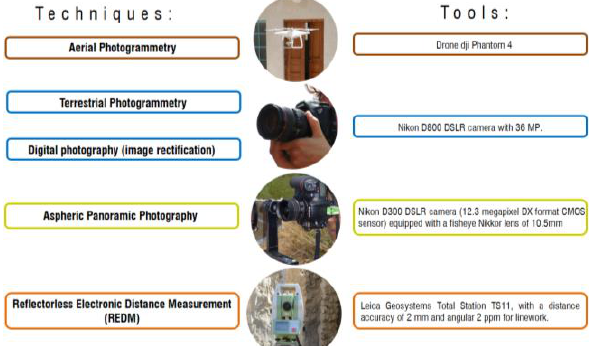
Figure 6 Image showing the used tools associated with each recording technique.